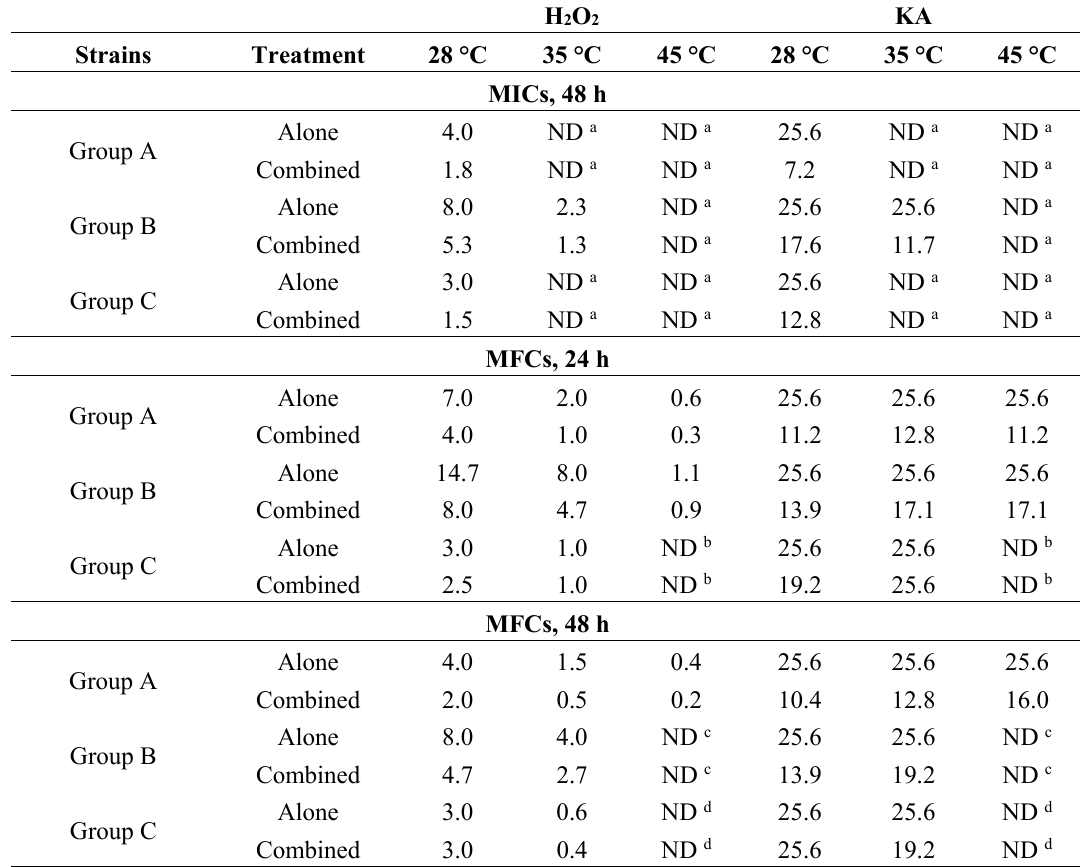
Table 3. Responses of Penicillium strains to chemosensitization (Summary). Data shown are comparison of MICs or MFCs of H 2 O 2 (antifungal oxidant) or KA (chemosensitizing agent) treated alone or in combination at different temperatures (MICs at 24 h are not determined due to no growth of all strains